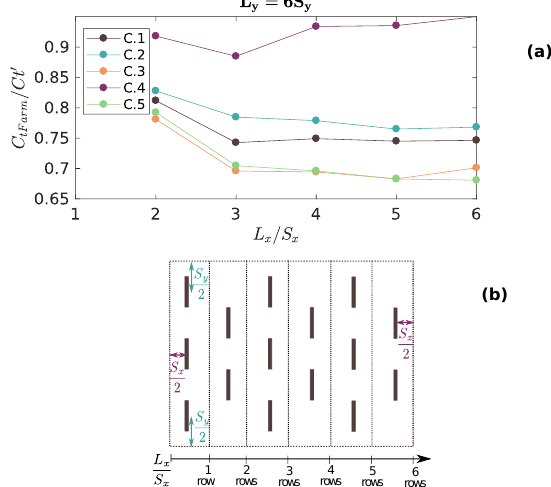
Figure 7. ( a ) variation of C tFarm due to changes in the size of the farm in the streamwise direction, L x . The ratio L x / S x can be interpreted as the number of rows of turbines; ( b ) schematic of the control volumes used for calculating C tFarm for various numbers of